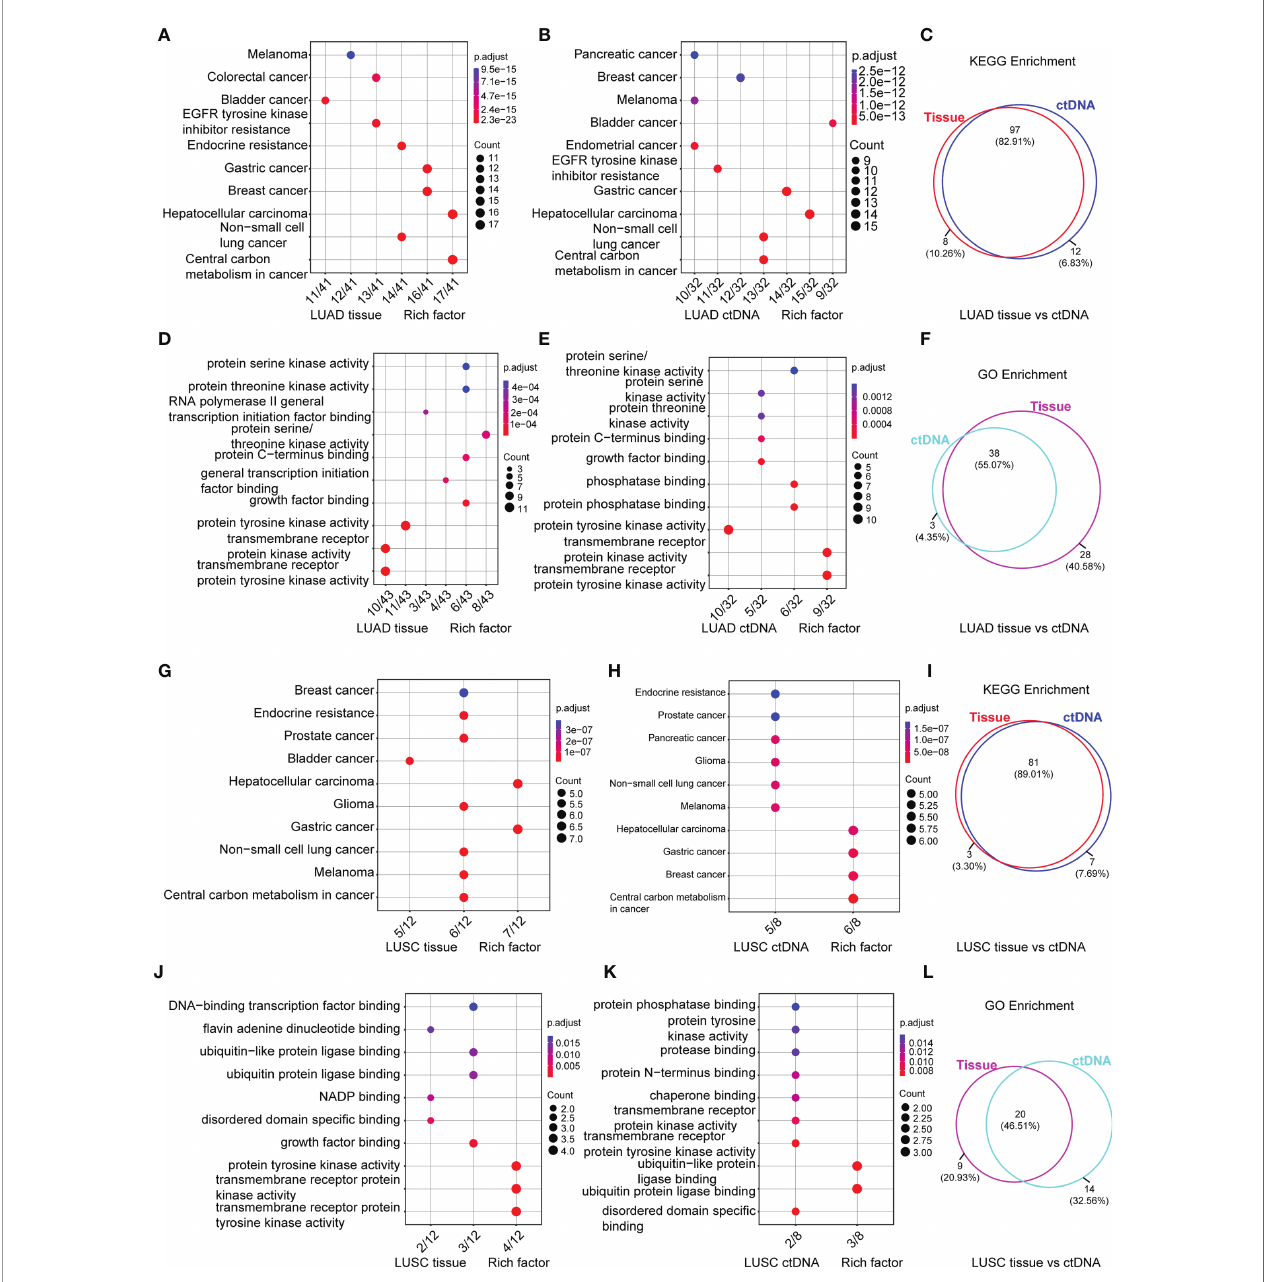
FIGURE 5 | Signalingpathwaysby KEGG (A, B, G, H) and functionalterms byGO (D,E,J, K) enrichment of somaticmutationsinLUAD tumor tissue DNA (n = 197) (A, D) , LUADctDNA (n= 143) (B, E) , LUSC tumor tissue DNA (n = 23) (G, J) and LUSC ctDNA (n = 31) (H,K) . Count means the number of mutated genes enriched inthis pathway. Venn diagram of signalingpathways (C,I) and functional terms (F, L) inLUAD (C,F) and LUSC (I, L) enriched byKEGG and